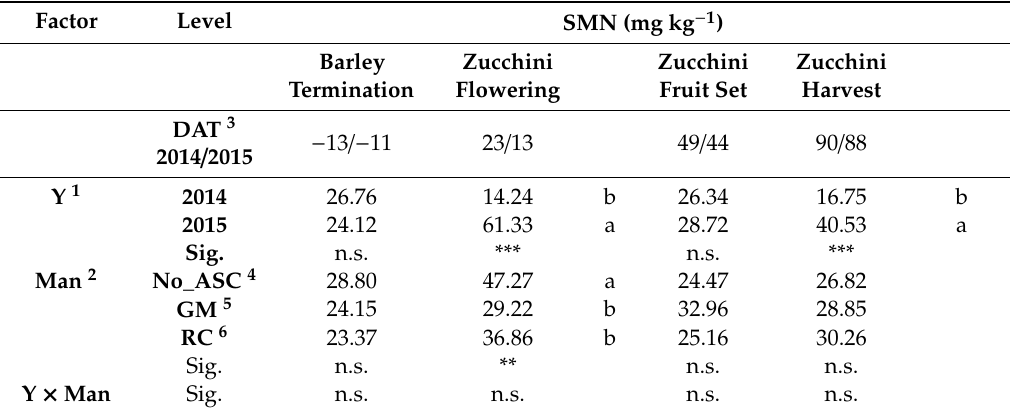
Table 2. Soil mineral N (SMN) during zucchini cycle